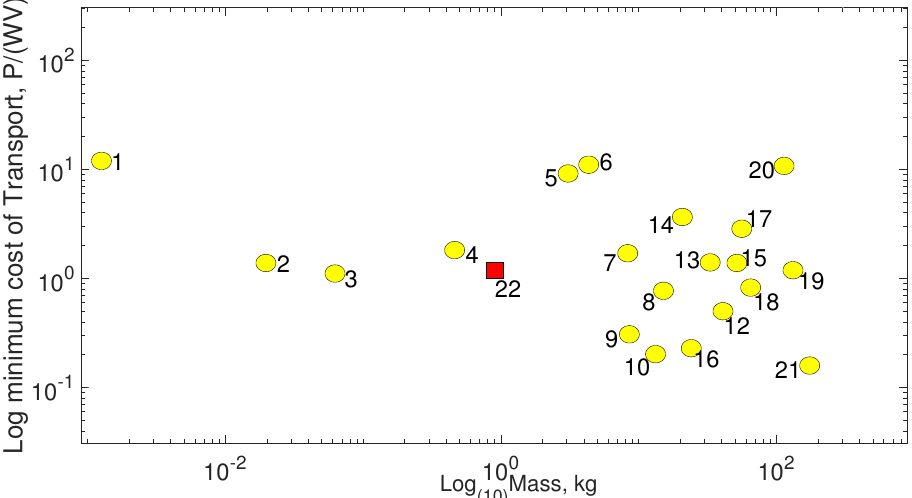
Figure 7. Comparison between monopod, biped, quadruped and hexapod robots in terms of COT. The reported robots are the following: 1 HAMR-VP; 2 X2-VelociROACH; 3 DASH; 4 iSprawl; 5 Chee-